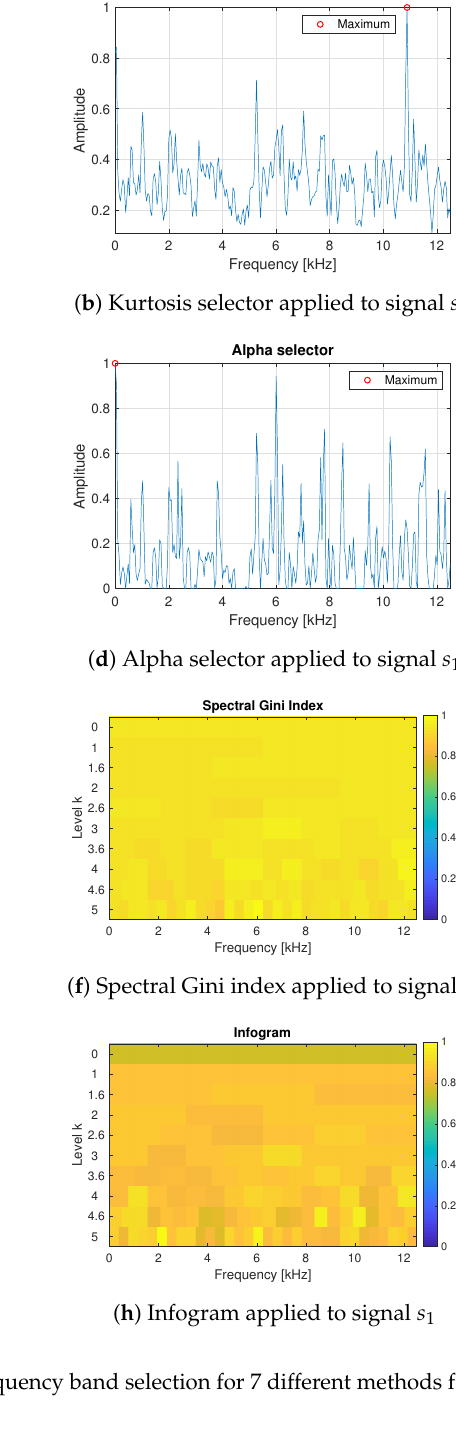
Figure A1. Normalized results of the informative frequency band selection for 7 different methods for the signal s 1